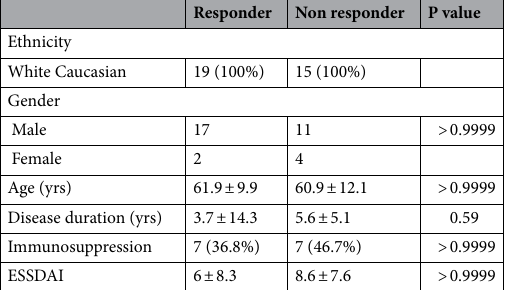
Table 1. Comparing the demographic and disease characteristics of those that responded and those that did not return questionnaires. ESSDAI, EULAR Sjögren’s syndrome disease activity index; yrs, years.